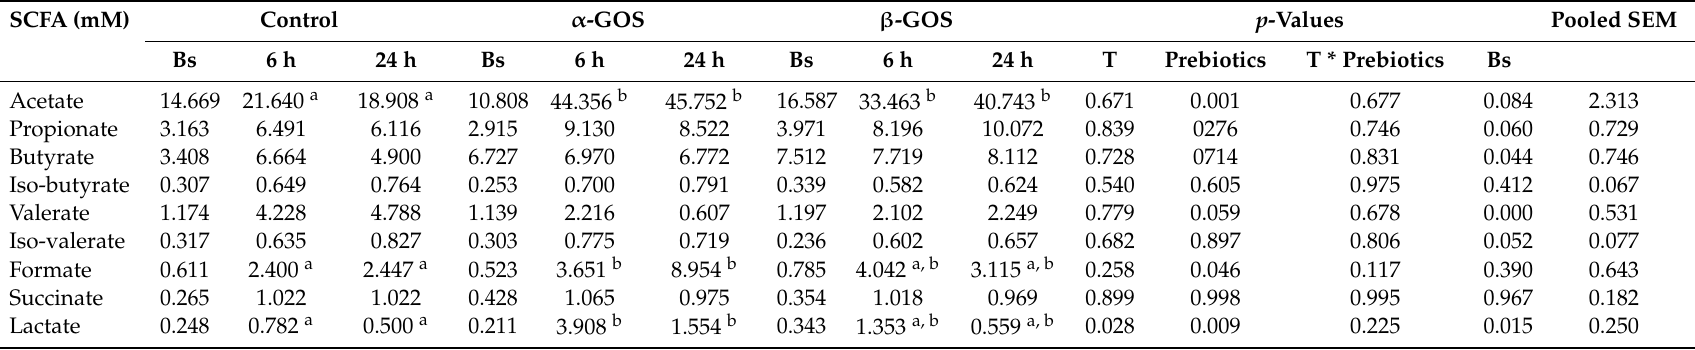
Table 5. Concentration (mM) of lactic acid and short-chain fatty acids (SCFA) infant faecal samples after non-fructosylated α -GOS and β -GOS